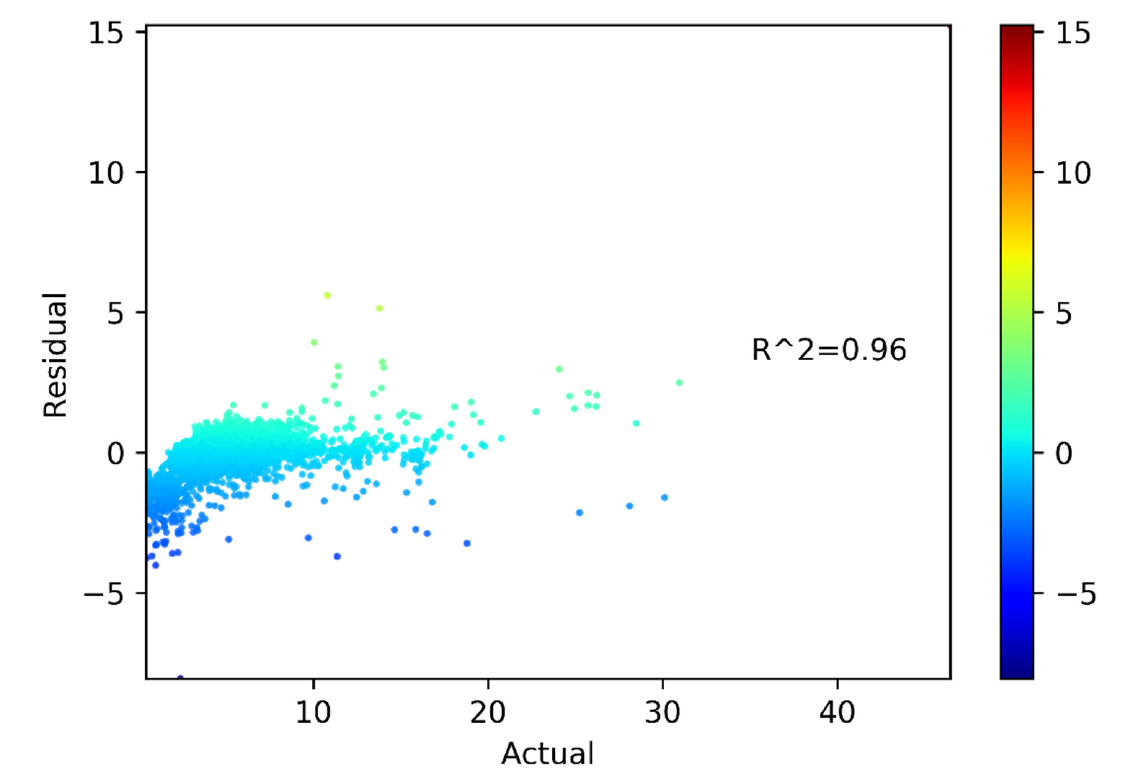
Figure 4. Property prices and residuals based on training set (RF).